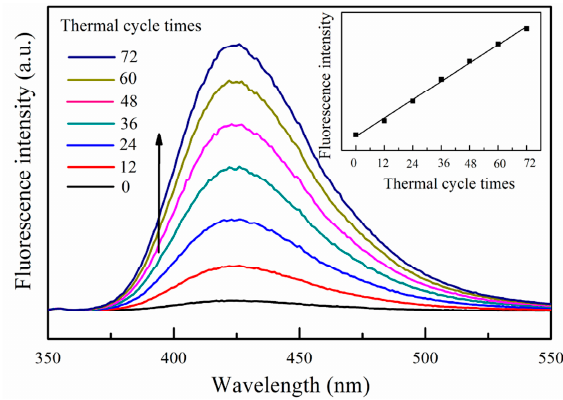
Figure 7. Fluorescence spectra for • OH trapping. The inset is fluorescence intensity peaked at 425 nm against the thermal cycle times.